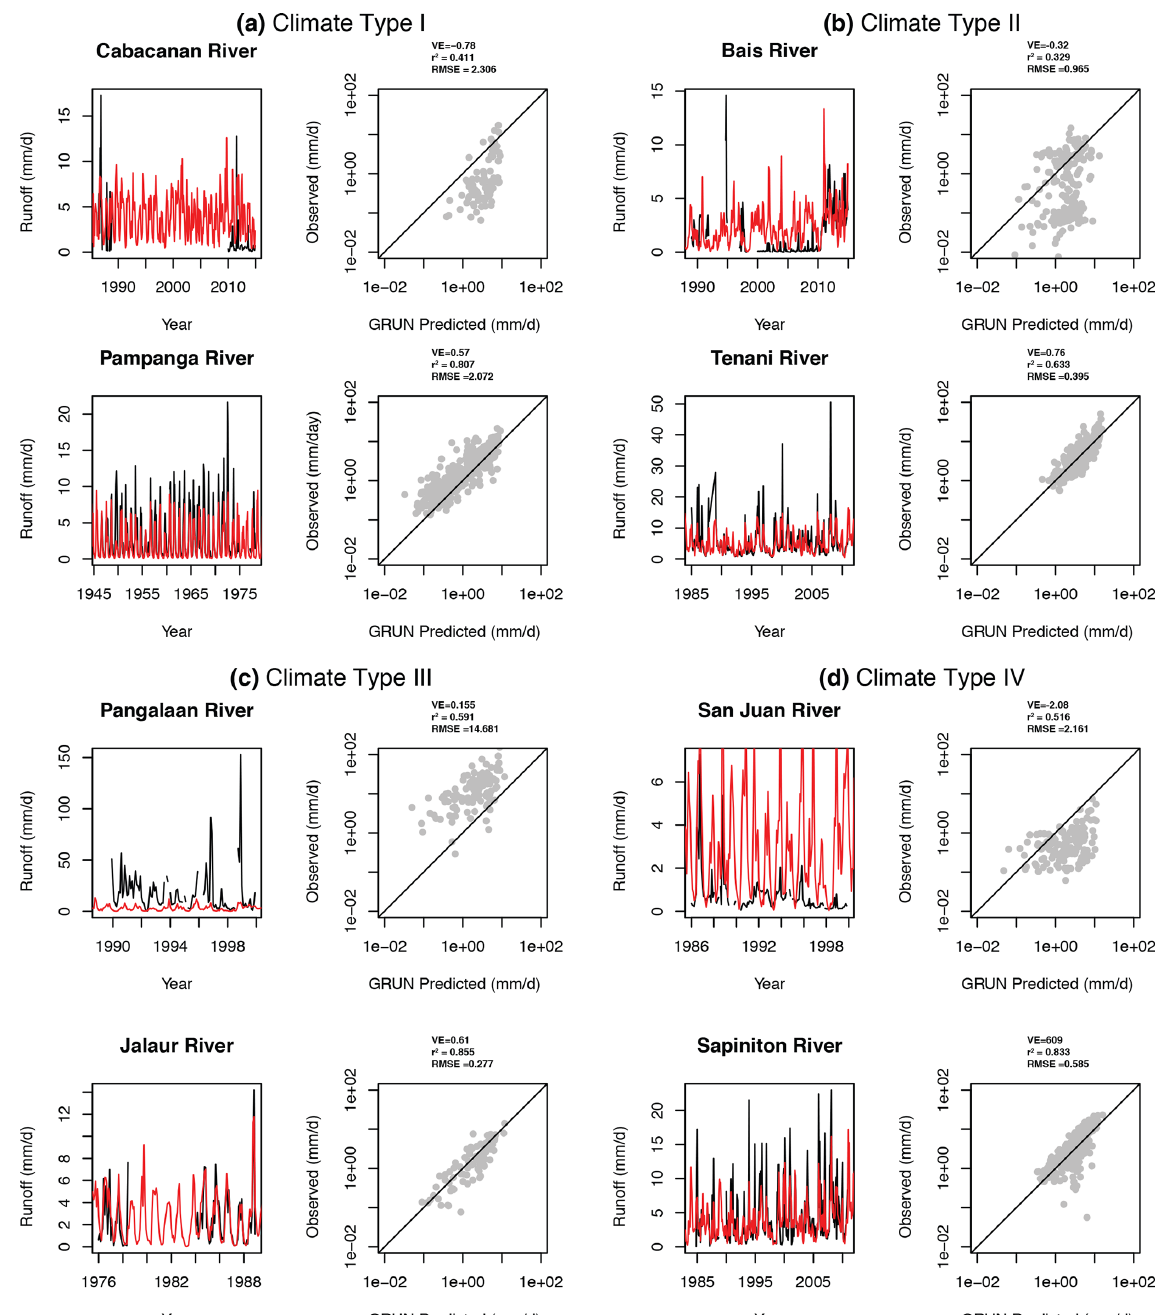
Figure 2. Example time series of GRUN-predicted (red lines) and observed (black lines) runoff values, and cross plots (log scale) with VE, r 2 , and RMSE values for the worst (a, b) and best (c, d) performing river basins within climate types I, II, III, and IV (panels a–d , respectively).